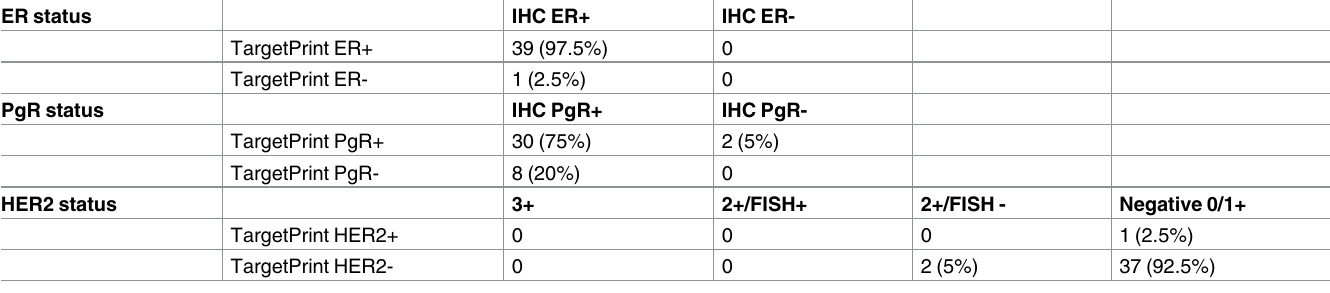
Table 5. Comparison of ER/PgR/HER2 status by IHC/FISH and